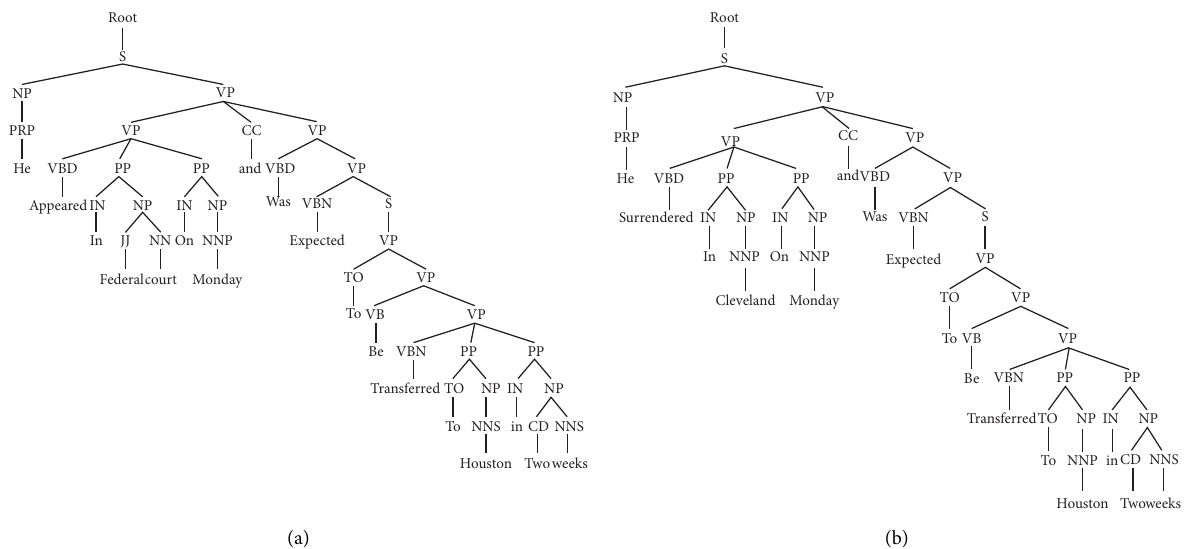
Figure 4: Nonparaphrase sentence pair-similar words with similar syntax structure. (a) S expected to be transferred to Houston in two weeks. (b) S 2 : He surrendered in Cleveland on Monday and was expected to be transferred to Houston in two